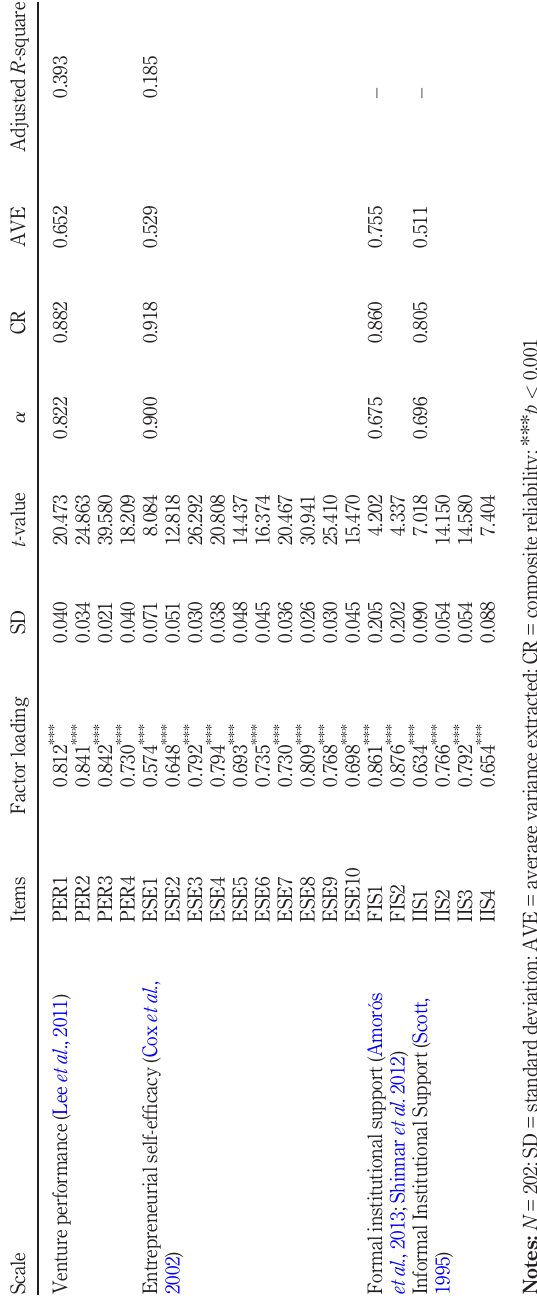
Table III. Measurement